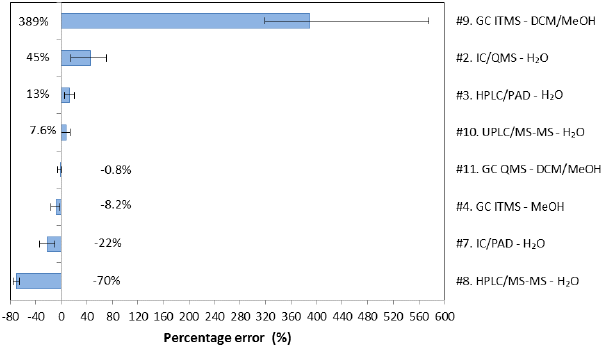
Figure 7. Calculated mean percentage error (PE) for each of the eight laboratories for which the galactosan to (cid:54) MA ratio could be derived. The PE was calculated according to Eq. (1) (Sect. 2.5) for each of the six sectors received by the participating laboratories. The mean PE for each laboratory accounts for the PE calculated for all six sectors. The laboratory number, ranging from 1 to 13, the analytical method and solvent used for extraction are mentioned at the right of the figure.